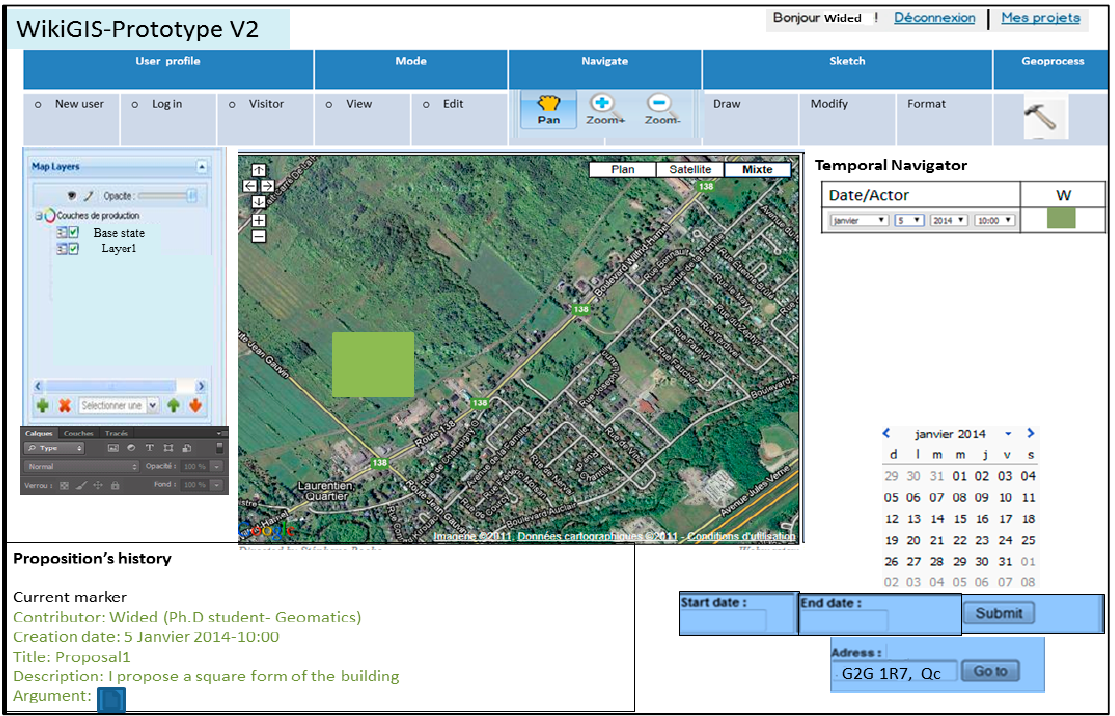
Figure 22. First proposal in the